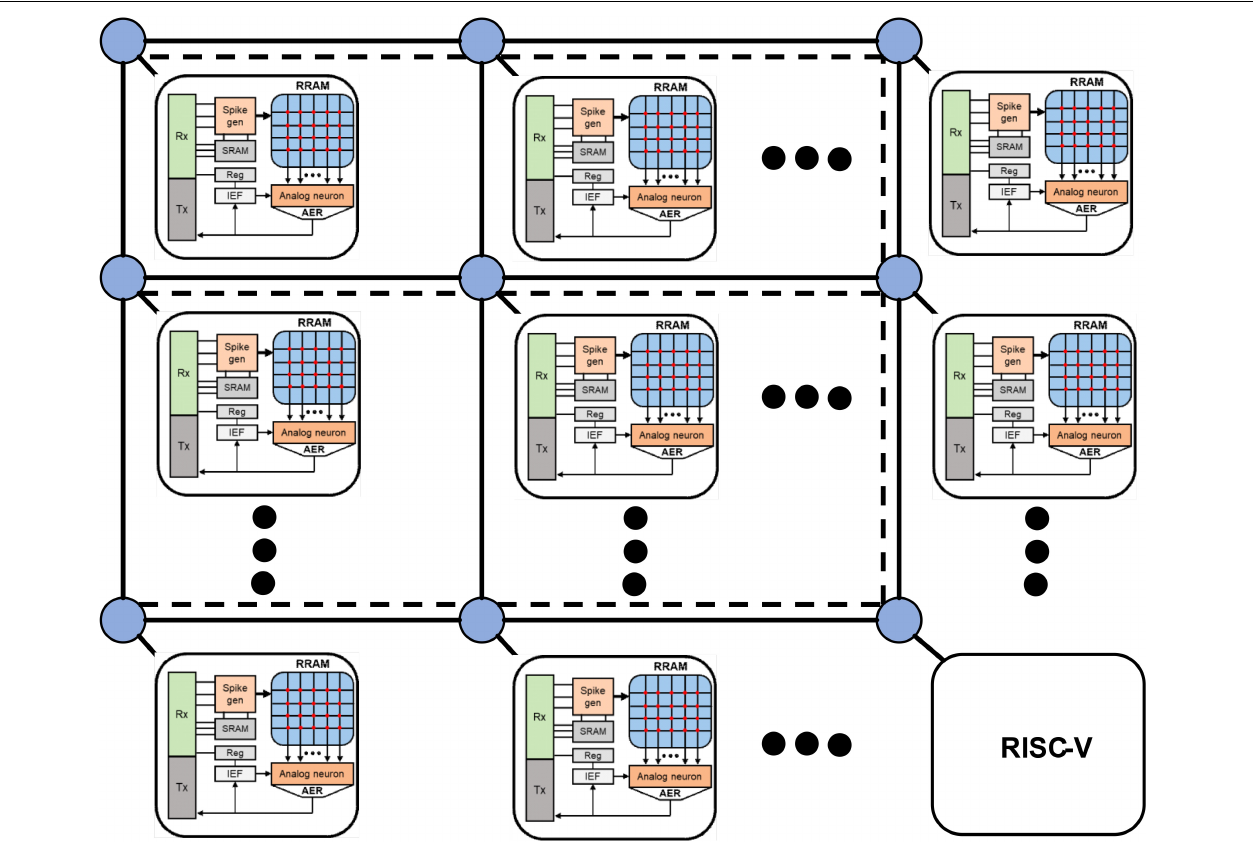
FIGURE 1 | SNN chip architecture. The SNN cores in the simulator consists of analog neurons, RRAM dendrites, SRAM axons and digital control circuit. The output of the neuron is converted into an address signal by an address event representation (AER) circuit. The entire SNN chip structure consists of 63 such SNN cores and a RISC-V instruction set